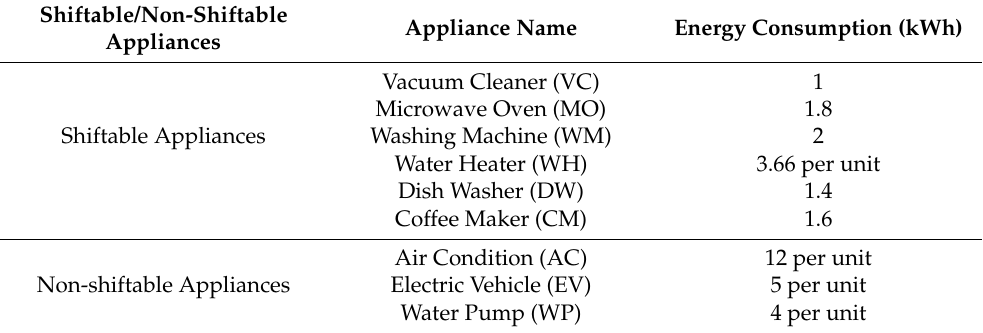
Table 1. Shiftable/non-shiftable residential Loads.